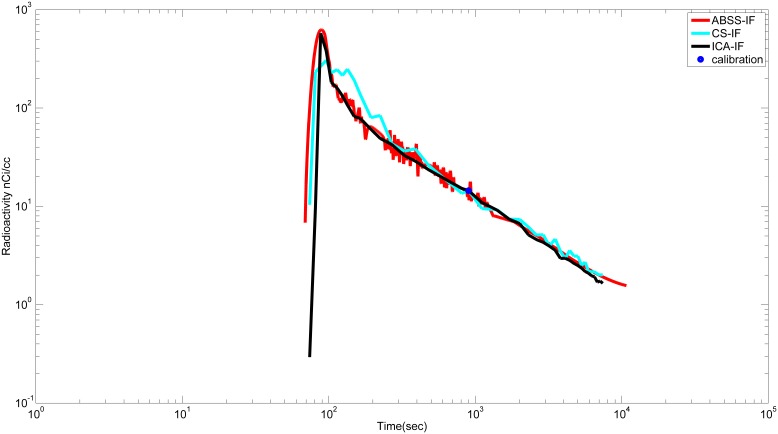
A typical double logarithmic scale of the input function estimated by CS and ICA plotted against the ABSS-IF.Two arterial blood samples were used to correct for a small inversion at 1.5 minutes (green point) and to calibrate curves at 15 minutes post injection (blue point).